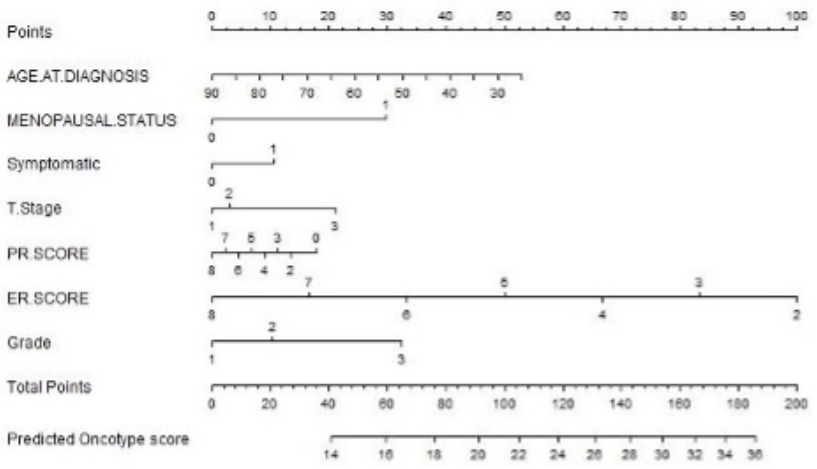
Figure 3. Static nomogram model capable of predicting a ‘surrogate’ recurrence score as a continu ‐ ous variable.